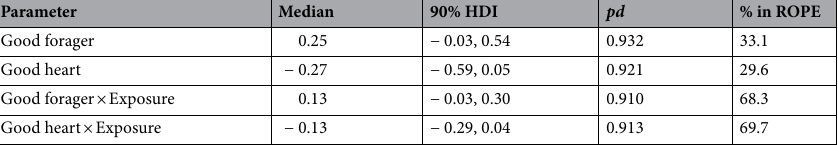
Table 2. Parameter estimates from the marginal posterior distributions of the model. The point estimate is the median value of the marginal posterior distribution. The 90% highest density interval (HDI) is the smallest interval that contains 90% of the posterior distribution, pd is the proportion of the posterior in the same direction as the median, and % in ROPE is the proportion of the posterior distribution falling between the region of practical equivalence (−